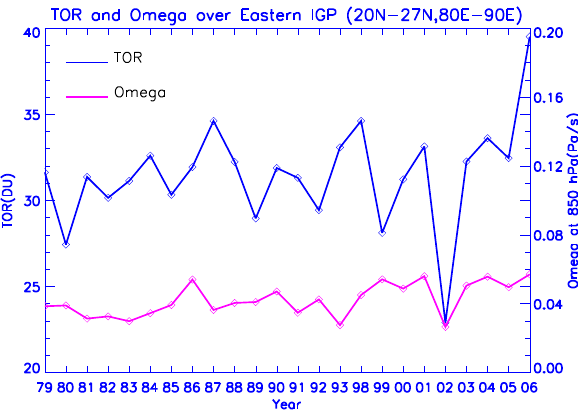
Fig. 13. TOR in January over Eastern IGP from 1979-2006 and the corresponding pressure tendency (omega, from the NCEP reanaly- ses). Positive values of omega indicate subsidence over the area for all years. Note that TOR data are not available from 1994 to